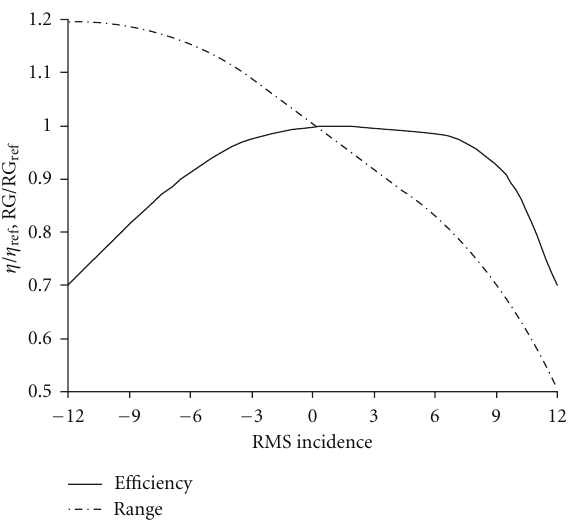
Figure 12: Incidence versus e ffi ciency and